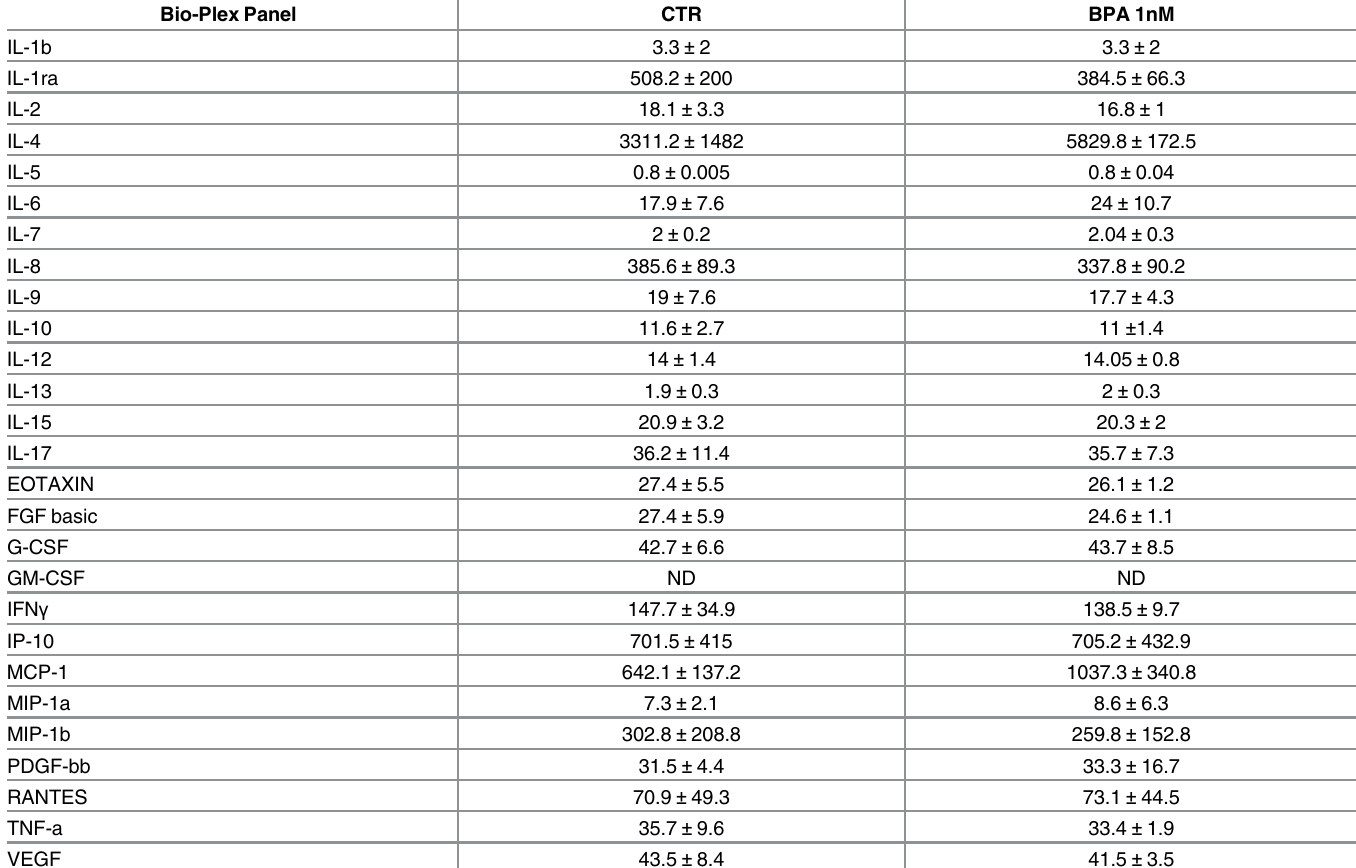
Table 1. Cytokines and Growth Factors released by dendritic cells, expressed as pg/ml. Bio-Plex